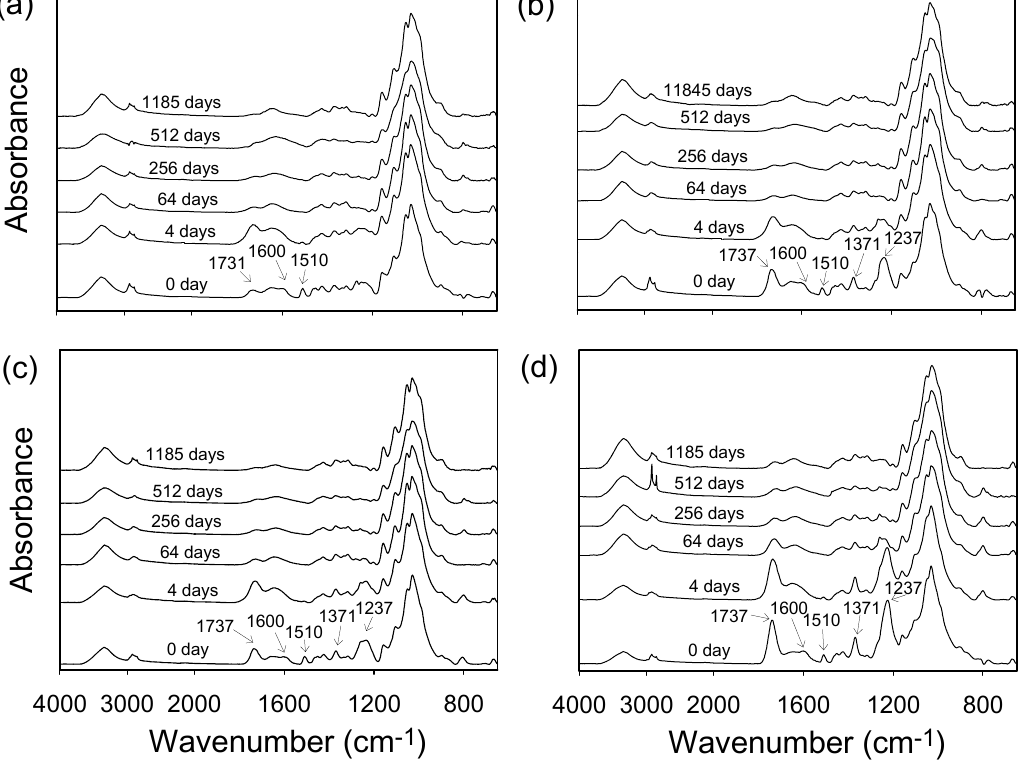
Figure 4. ATR-FTIR spectra of vWPCs with unmodified veneers ( a ), WPG 6 ( b ), WPG 11 ( c ), and WPG 16 ( d ) acetylated veneers during 1185 days of natural